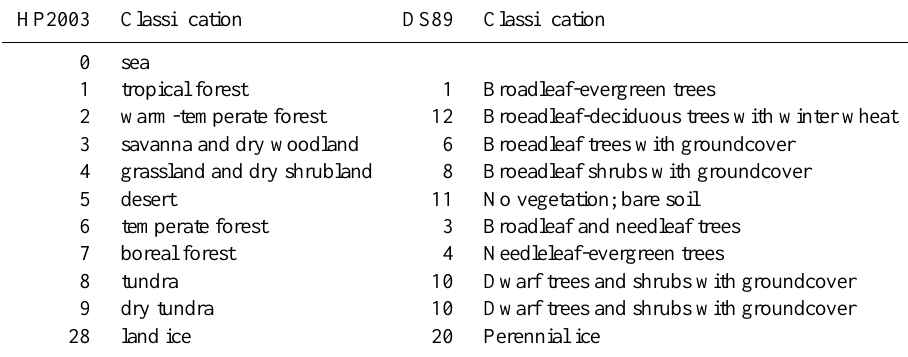
Fig. 3. Boundary conditions. Land-ice-ocean mask for (a) pre-industrial, and (b) Pliocene scenarios. (c) Grid-cell specific deviations of land and ocean between Pliocene and pre-industrial masks, with land (blue) and ocean (red) cells present in Pliocene scenario and absent in pre-industrial. Note that pre-industrial mask is adapated to Pliocene mask for anomaly calculation (see text). Table 1. Vegetation megabiomes of Harrison and Prentice (2003) (HP2003) reclassified into Dorman and Sellers (1989) biomes